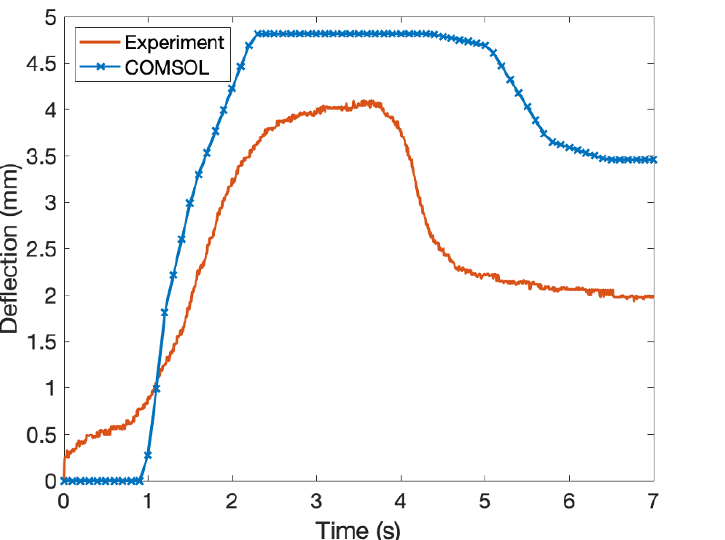
Figure 10. Deflection of the mid-point of the SMC over time obtained from the experiment and COMSOL simulation during heating and cooling cycle for a 2.2 A input current under the isothermal domain